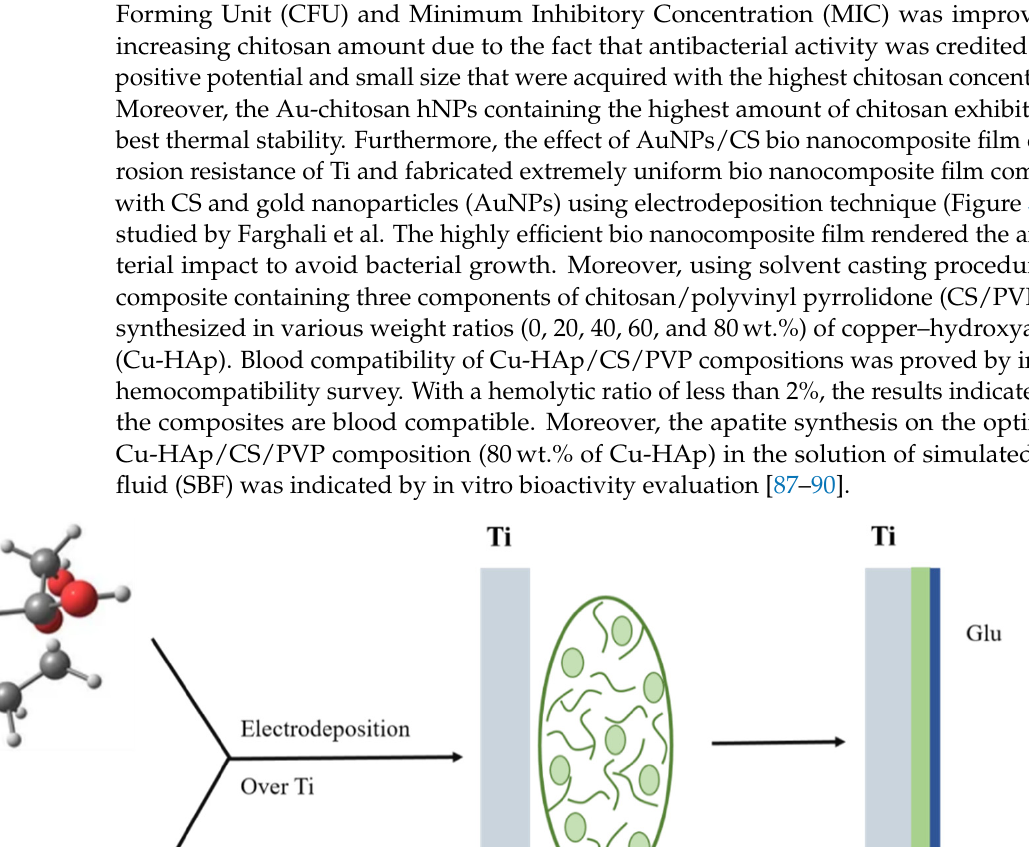
Table 1. A list of various chitosan composites for applications of implant and dental engineering.